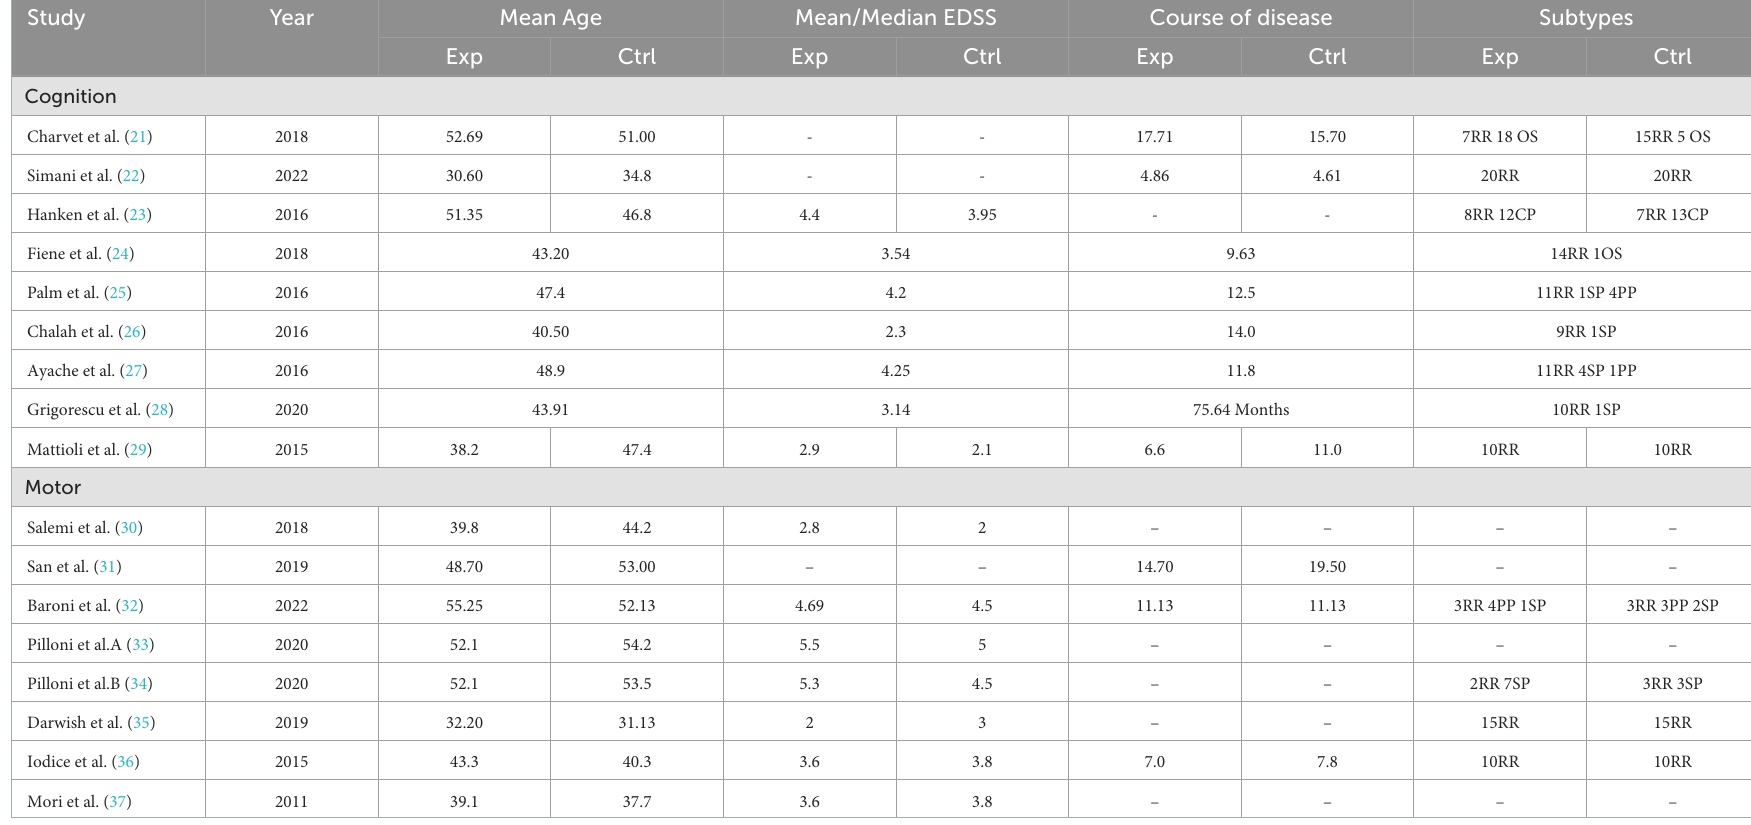
TABLE 3 The characteristics of